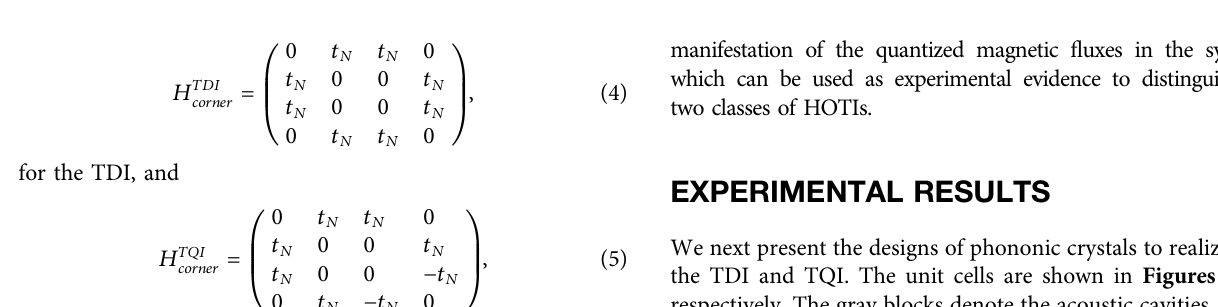
FIGURE2|(A – B) Thedesigns ofphononiccrystal unit cellsoftheTDI (A) and TQI (B) . (C – D) Thebandstructures oftheTDI (C) andTQI (D) .Theinsetin each plot denotes the fi rst Brillouin